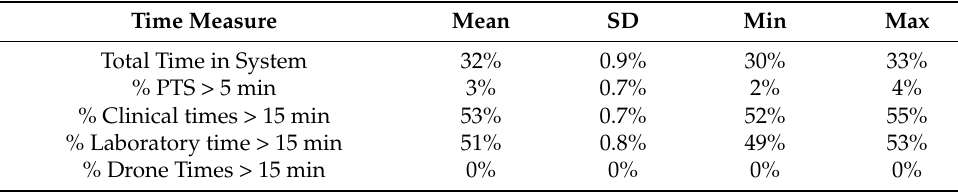
Table 4. Percent of simulations violating the maximum allowed total time of 60